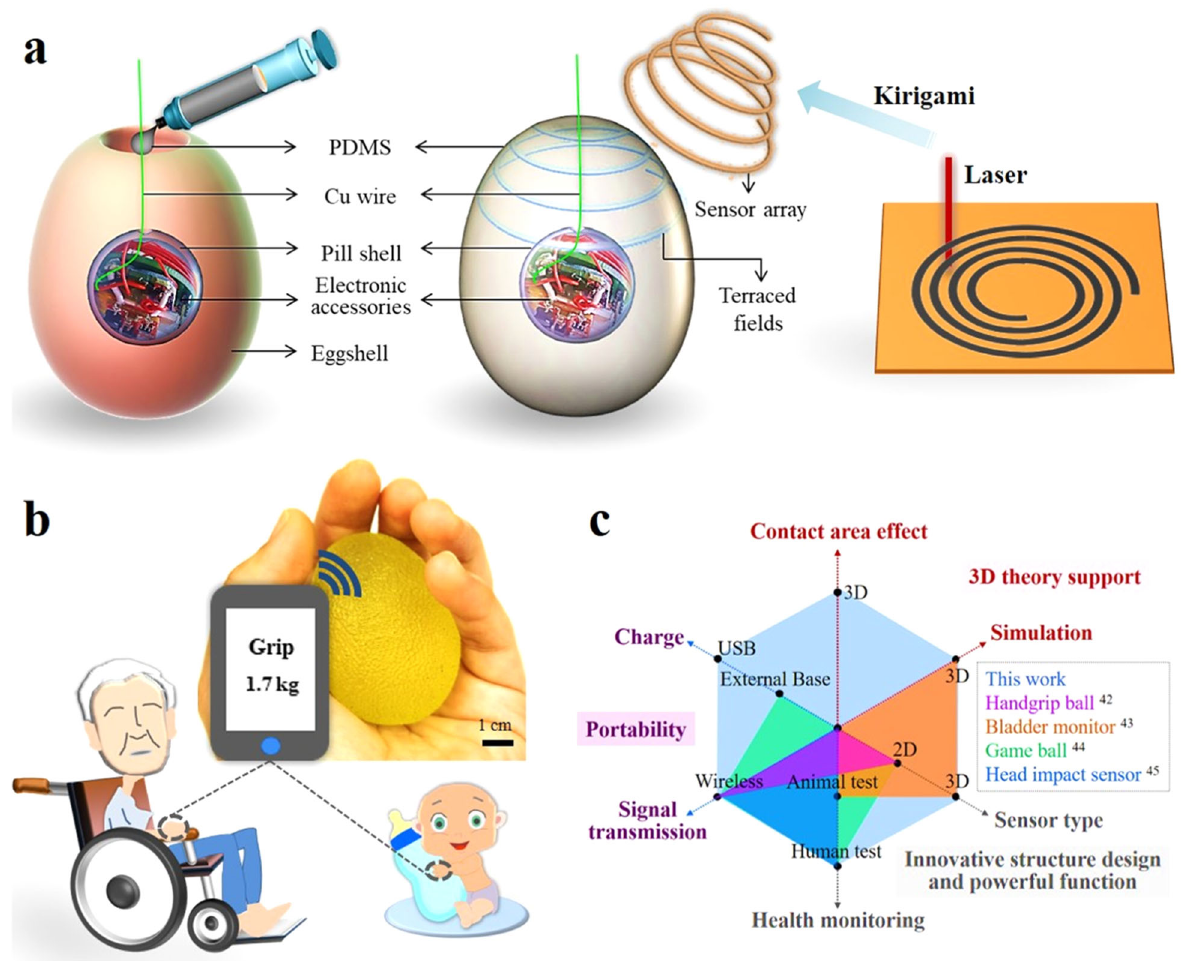
Fig. 1 Schematic of the smart ball sensor fabricated by laser kirigami of graphene for personalized long-term monitoring of the small grip strength. a Fabrication of the smart ball sensor. b Personalized long-term monitoring of the small grip strength, including customizations of ball size and sensing range to enable tiny enough for baby hand and sensitive enough for small grip people. c Comparison of the existed smart ball